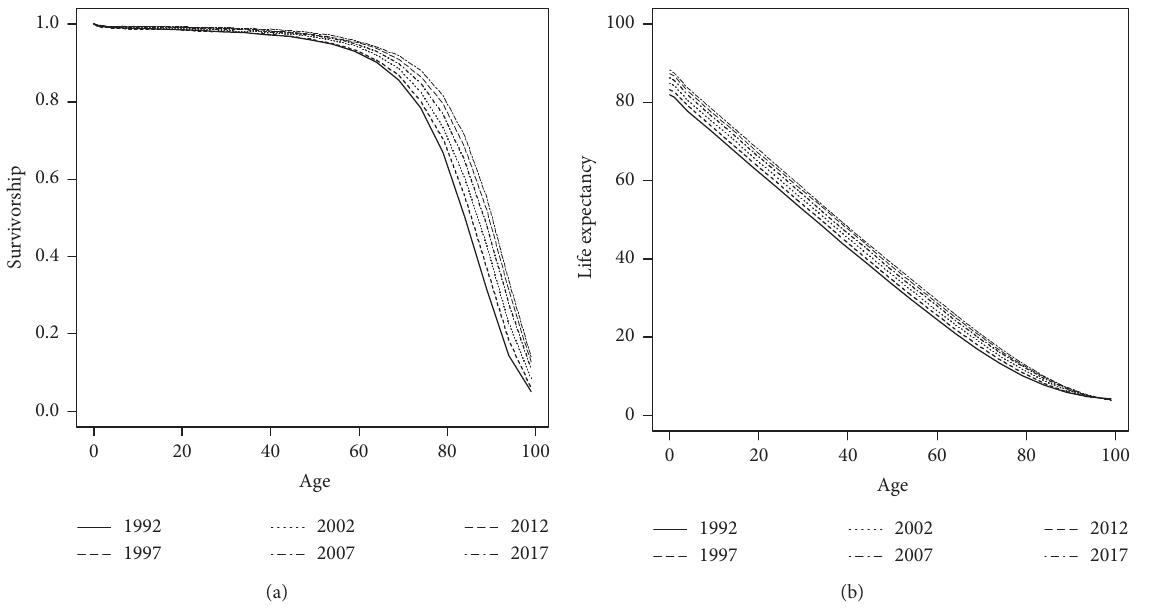
Figure 2: Age-specific survivorship and life expectance for the six